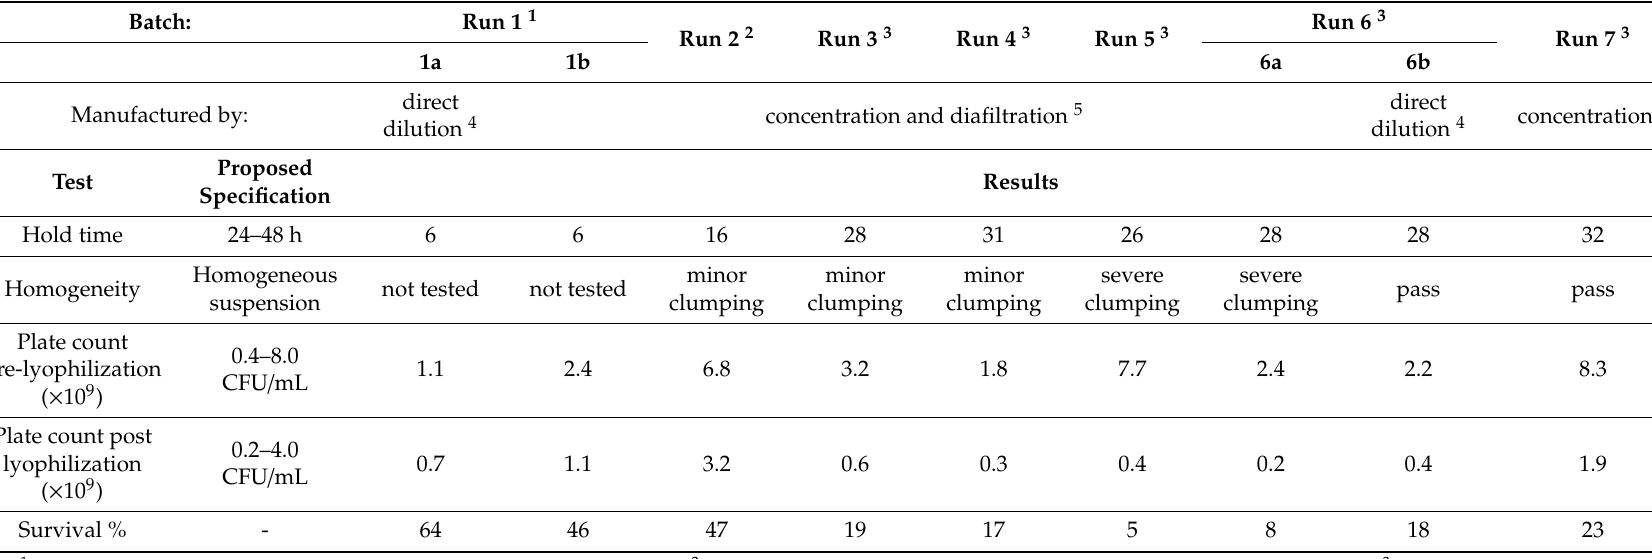
Table 4. Overview of the various runs carried out in a 50-L single-use bioreactor with 20 L medium, comparing di ff erent harvest methods. Batch: Run 1 1 Run 2 2 Run 3 3 Run 4 3